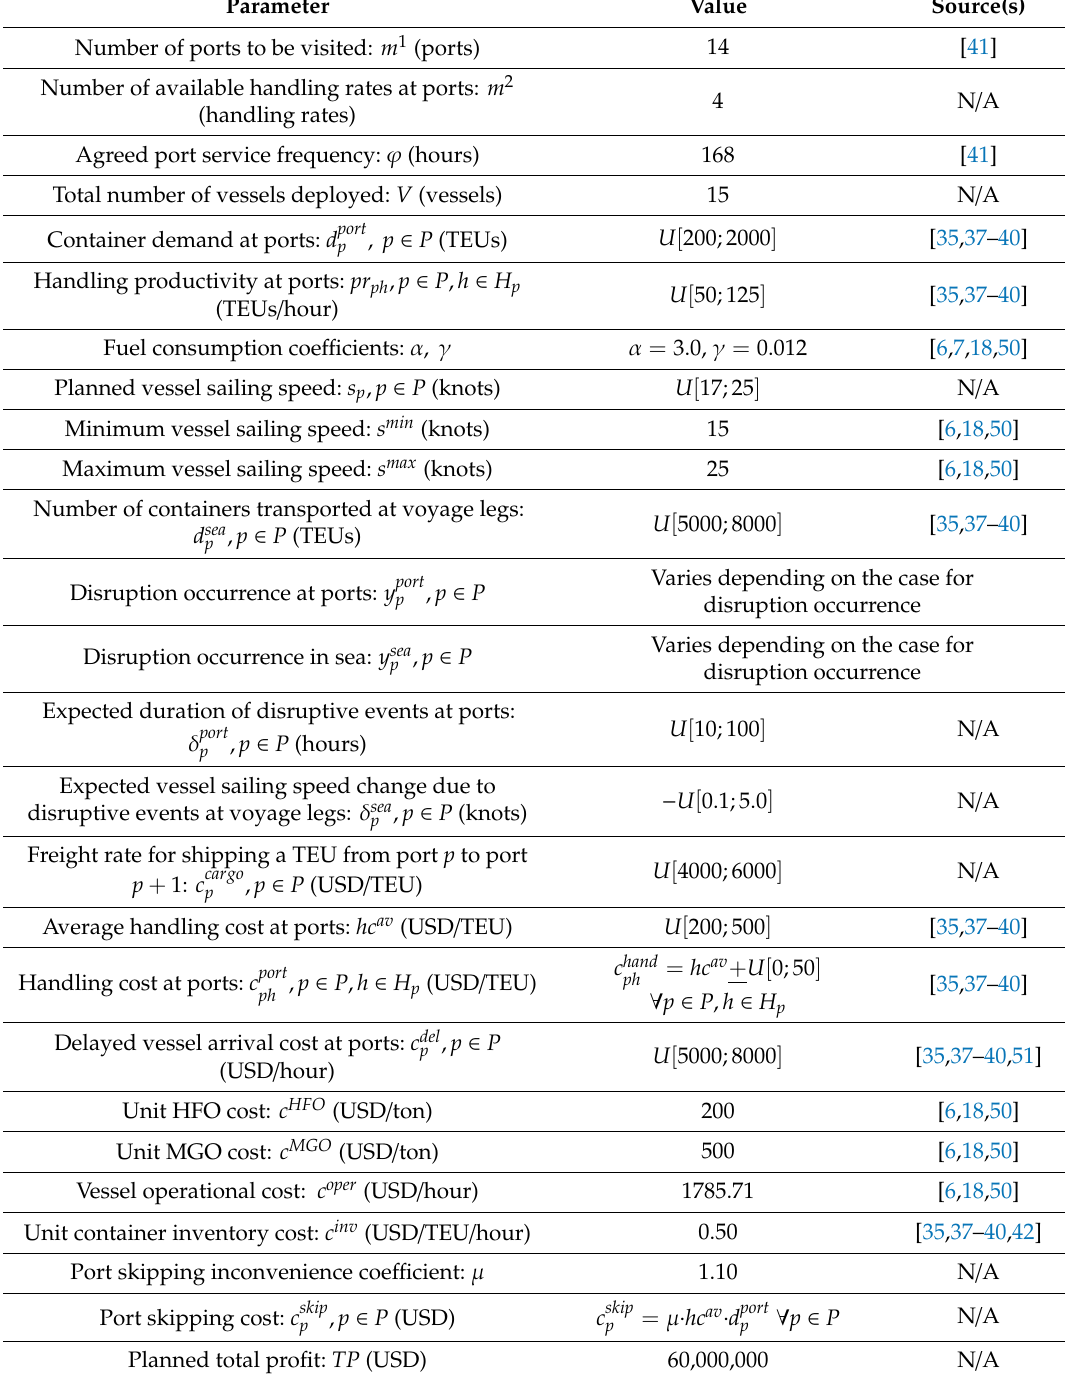
Table 1. The parameter values used for the numerical